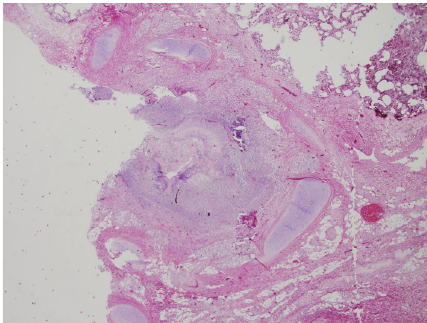
Figure 6: Histopathology: 10-fold magnification and H+E stain of a large bronchus demonstrating an entirely obstructed